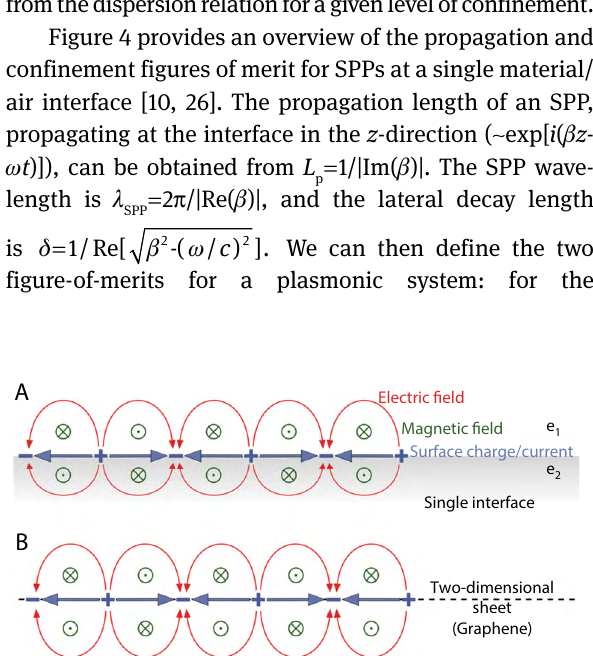
Figure 3 TM surface modes of (A) a single interface structure, (B) a two-dimensional sheet material (e.g.,